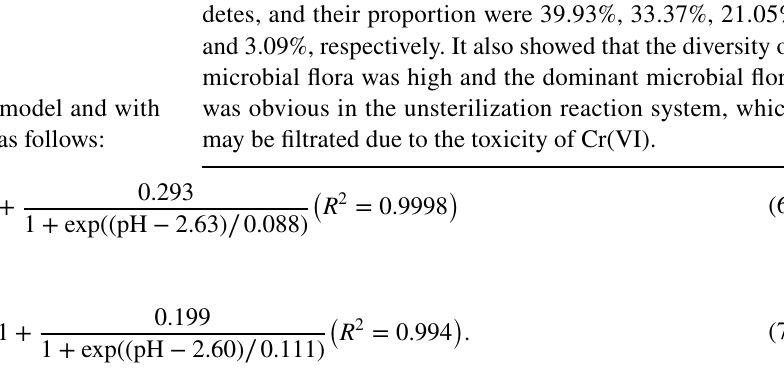
obs and pH in the reaction on unster-